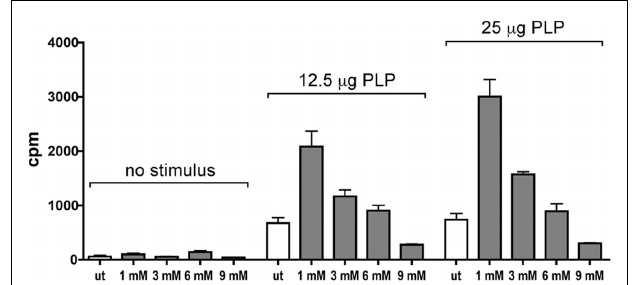
FIGURE 3 | Changes in the proliferative capacity ofT cells were assessed in a 3 [H]thymidine assay. T cells incubated withVSOP concentrations of 1–9mM Fe/ml were compared to unlabeled cells (ut). Proliferation rates were determined in the presence of the specific